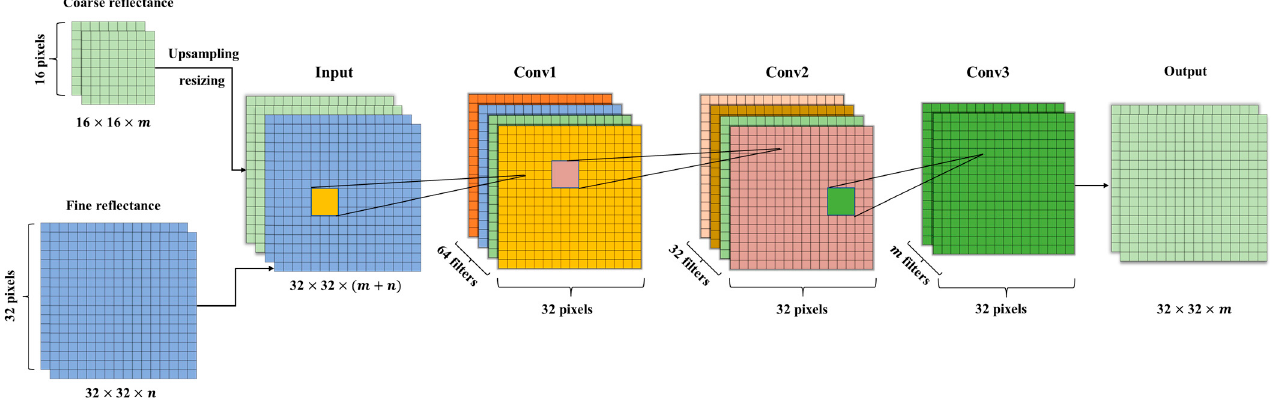
Figure 2. The structure of the DRCNN. The m and n of the input part represent the dimensions of the input coarse reflectance and fine reflectance, respectively.